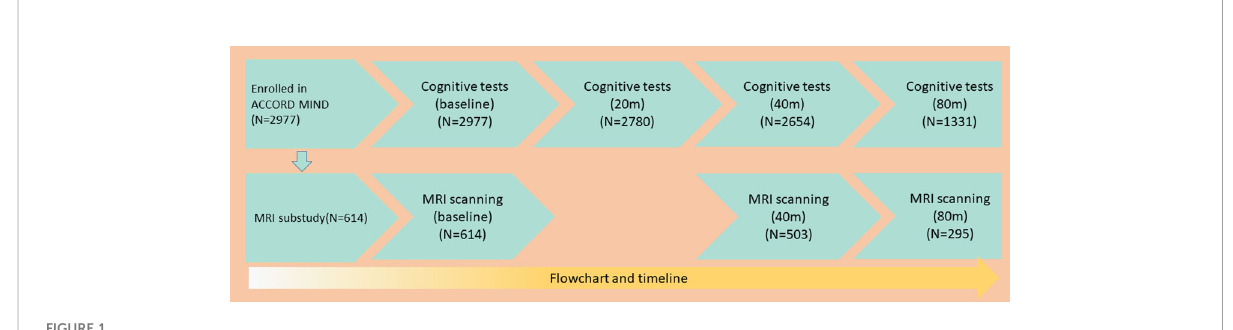
FIGURE 1 The study ’ s fl owchart and